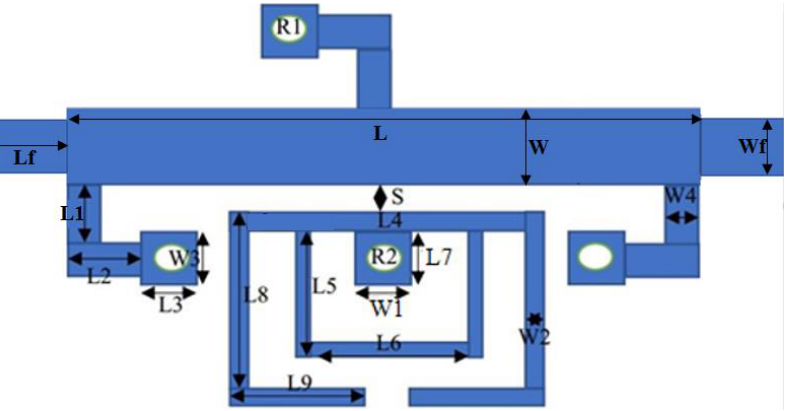
Figure 12. The presented architecture of the SUWB-BPF with a quad-mode stub-loaded resonator. Table 1. Dimensions in millimeter (mm) of the proposed SUWB-BPF with a stub-loaded resonator.